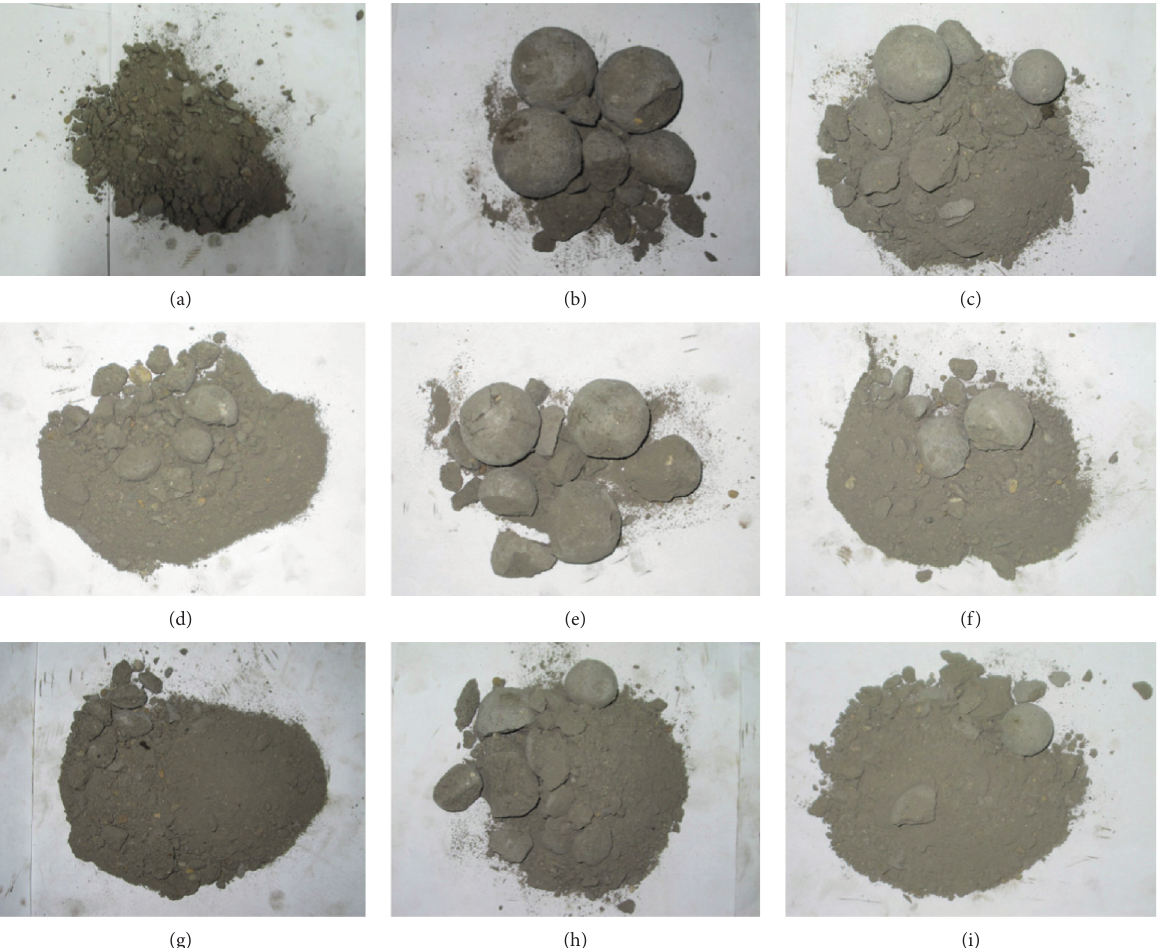
Figure 12: The breakage of 3 and 4 cm mixed cement mortar particles under the loading of 30, 40, and 50kN: (a–c) in the surface layer; (d–f) in the medium layer; (g–i) in the bottom